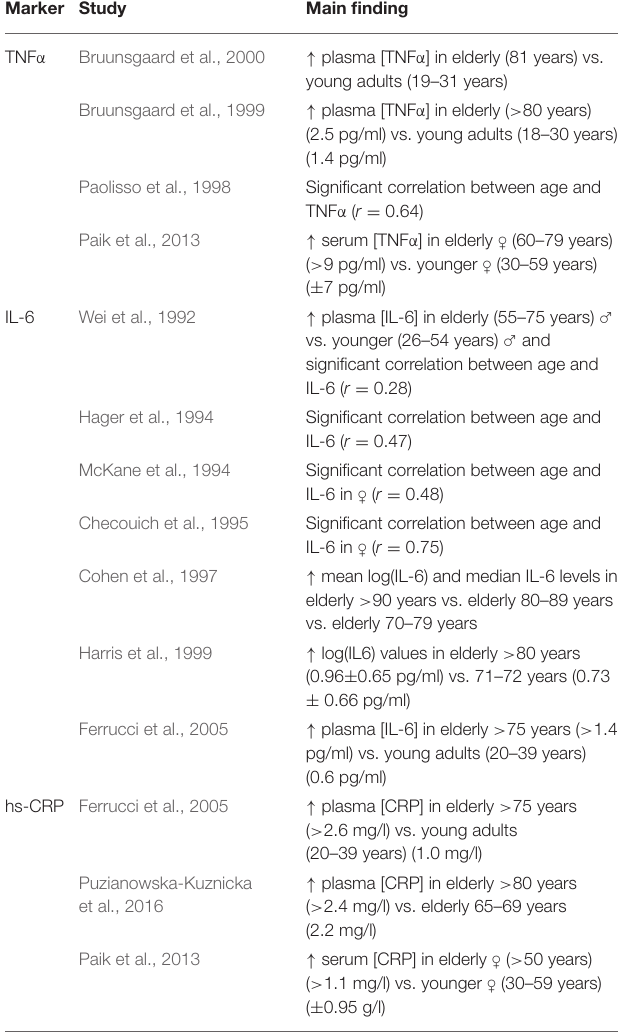
TABLE 1 | Studies reporting plasma/serum levels of pro-inflammatory markers with aging. Marker